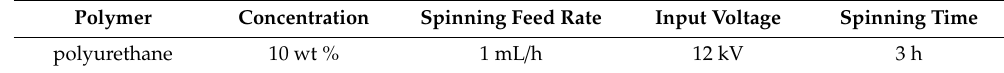
Table 3. Summarized conditions of electrospinning.